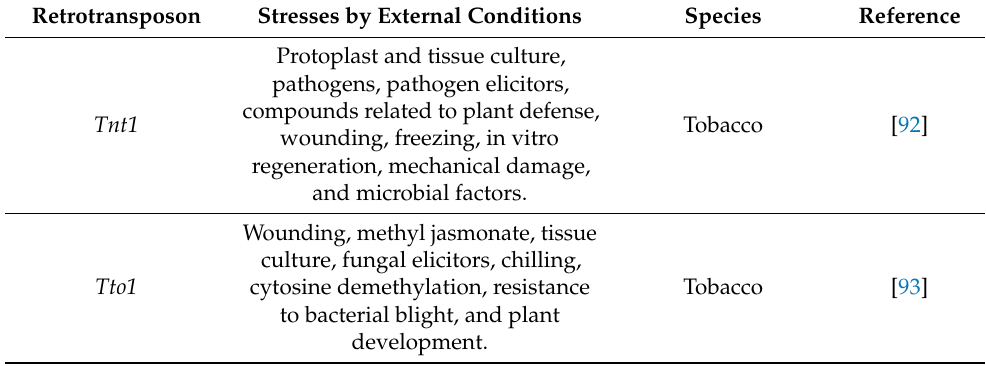
Table 2. Stress-activatedretrotransposonsreportedinplantgenomes. Withinformationfrom